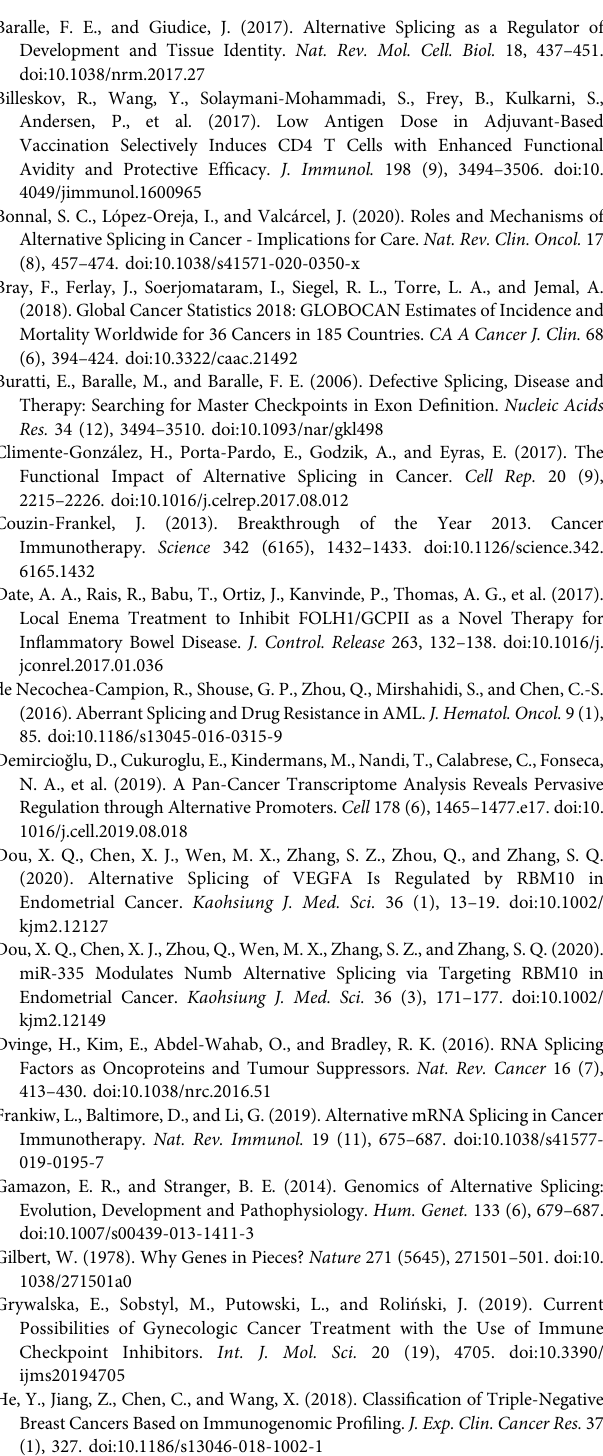
Supplementary Figure S4 | Relationship between the gene copy number of CYB561 and the quantity of six immune cells using the TIMER database.